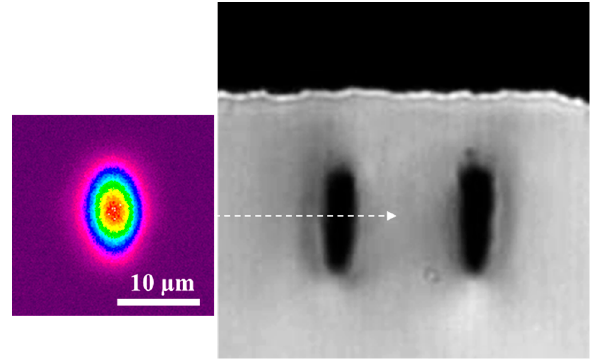
Figure 4. Side view of type II waveguide for 1550 nm guiding. The separation between the modification tracks was 19 µm and the depth was 20 µm. The laser processing conditions were 500 kHz repetition rate, 60 nJ pulse energy, and 0.5 mm/s scan speed. Single mode guiding was obtained at 1550 nm. Note that the color linear scale varying from 0 (violet) to 1 (red) indicates the relative intensity of the mode profile, normalized to the peak intensity. The 10 µm scale bar is the same for the mode and microscope image.